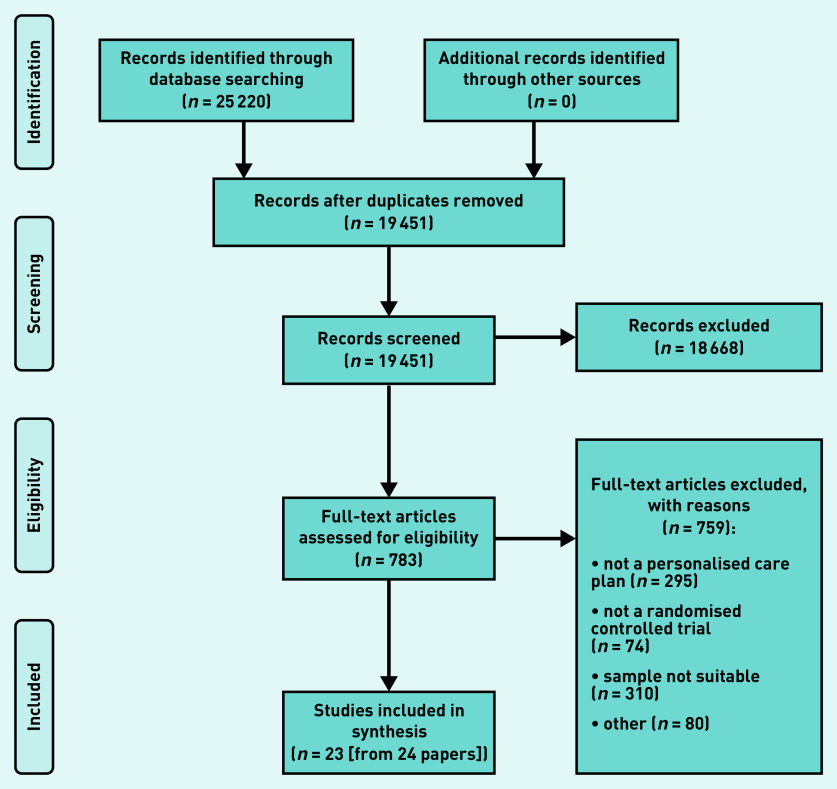
PRISMA flow diagram.